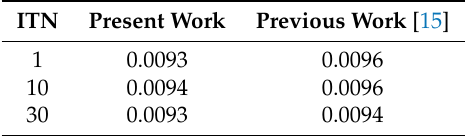
Table 3. Comparison of error estimates of saturation (cid:107) s n + 1, k + 1 w − s n + 1 w (cid:107) with a previous